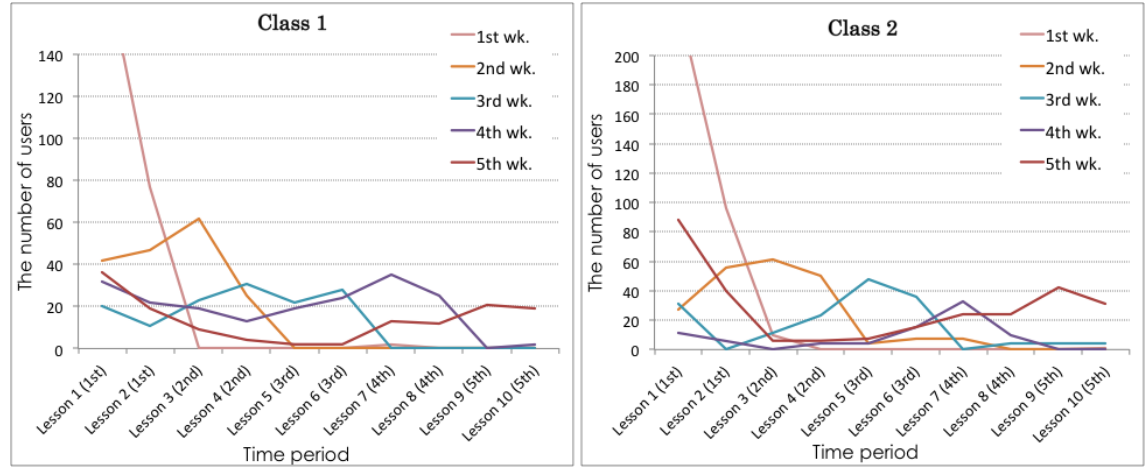
Figure 5 The number of participants who attempted online exams